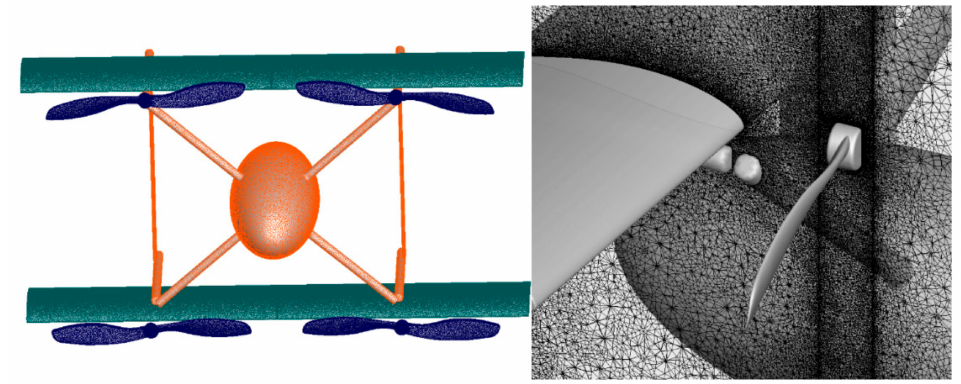
Figure 4. Grid representation of